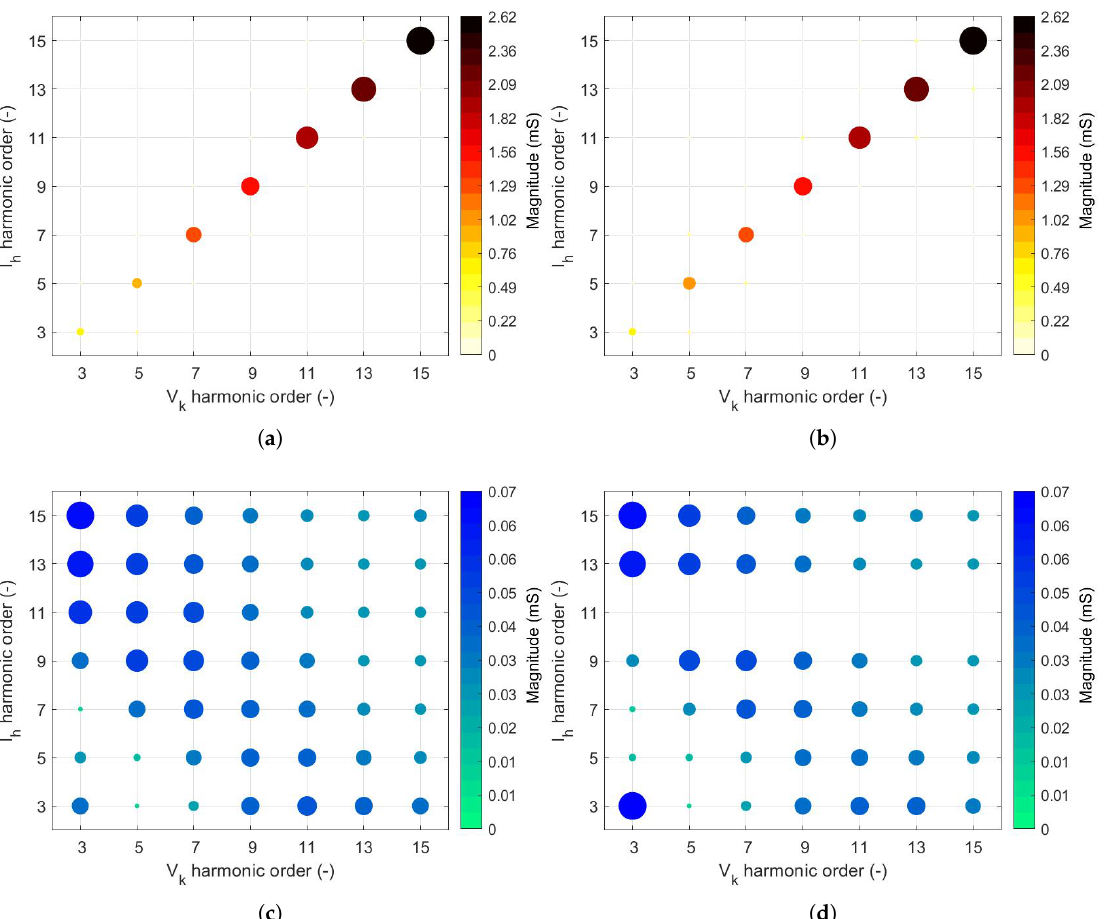
Figure 20. Magnitude of frequency coupling matrices of the Type D LED lamp: ( a ) Y + FT; ( b ) Y + PT; ( c ) Y − FT; and ( d ) Y −